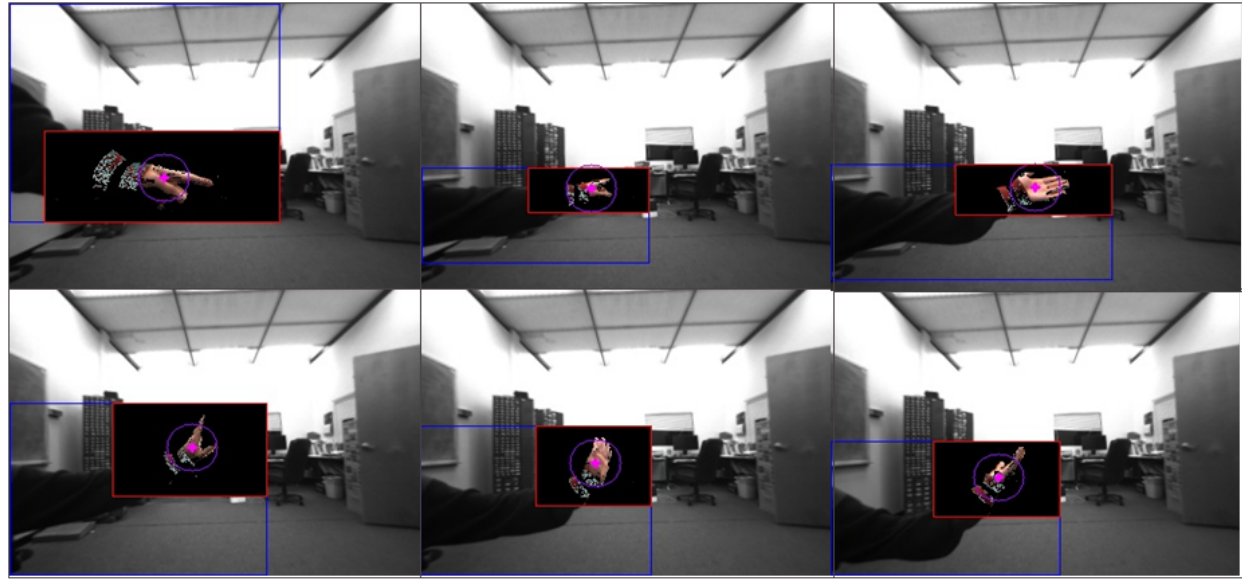
Figure 10. Results of hand detection.